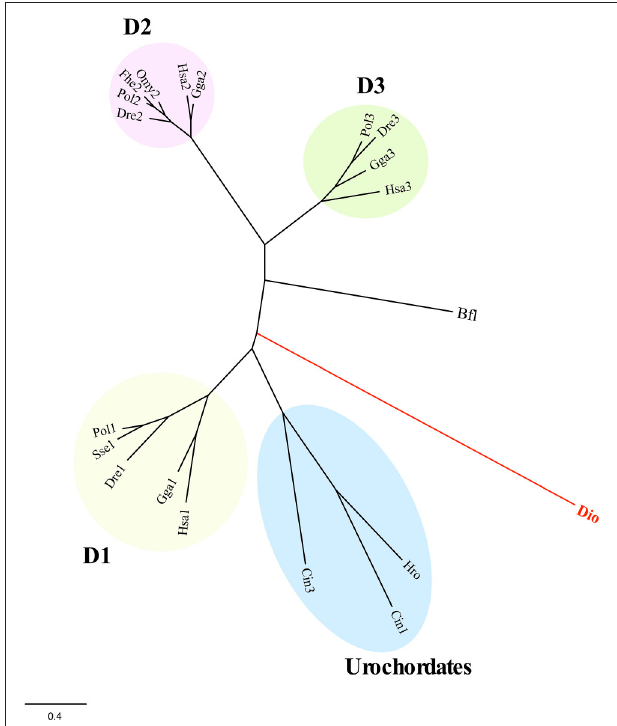
FIGURE 2 | Maximum likelihood phylogeny of T. lutea deiodinase ( dio ) and counterpart from vertebrates and invertebrates (see Supplementary data sheet 2). The D1-, D2-, and D3-type deiodinases in vertebrates and the urochordates branch are indicated. The B. floridae (Bfl) was used as outgroup to root tree. The scale for branch length (0.4 substitutions/site) is shown below the tree. Bfl, Branchiostoma floridae ; Cio, Ciona intestinalis; Dre, Danio rerio : Fhe, Fundulus heteroclitus ; Gga, Gallus gallus; Hro, Halocynthia roretzi ; Hsa, Homo sapiens ; Omy, Oncorhynchus mykiss ; Pol, Paralichthys olivaceus ; Sse, Solea senegalensis